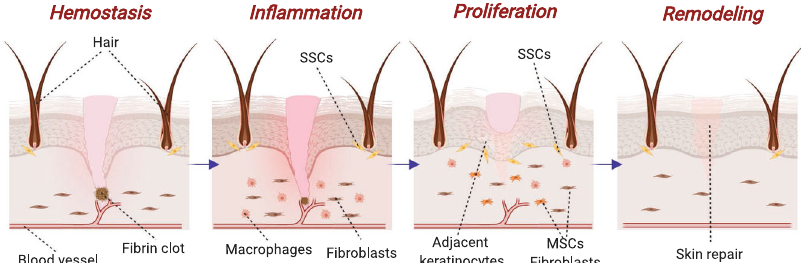
Fig. 1 Phases of skin wound healing process. Hemostasis: activation of fi brin is responsible of clot formation and bleeding is stopped. In fl ammation: damaged cells are phagocyted and factors are released to provoke cell migration and proliferation. Proliferation: cells such as dermal fi broblasts, MSCs and SSCs (mesenchymal and skin stem cells) achieve wound ’ s site and form a provisional extracellular matrix. Remodeling: collagen fi bers are realigned, and residues are removed. Created with